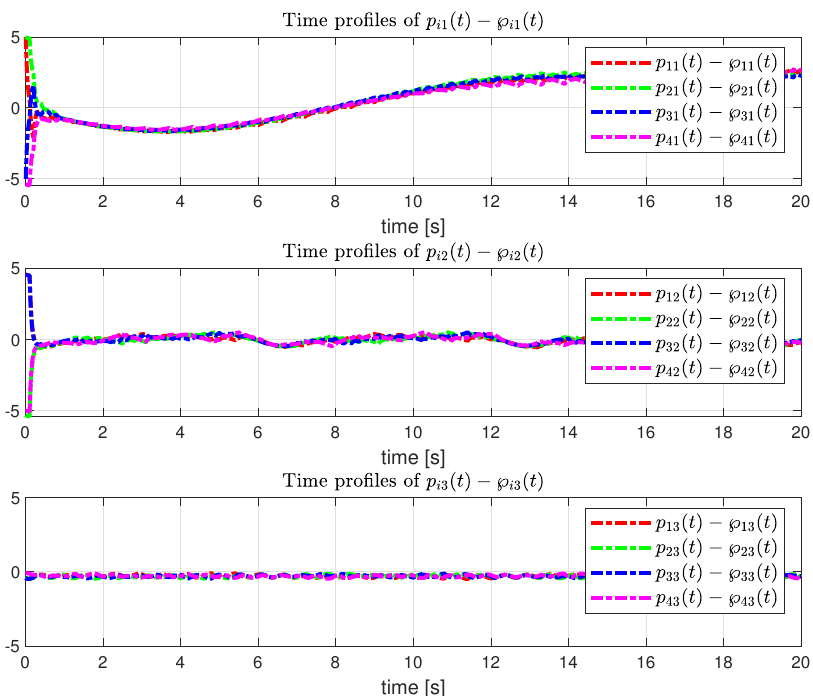
Figure 14. Performance of the pseudo position estimator subject to velocity measurement noise with n V = 1.